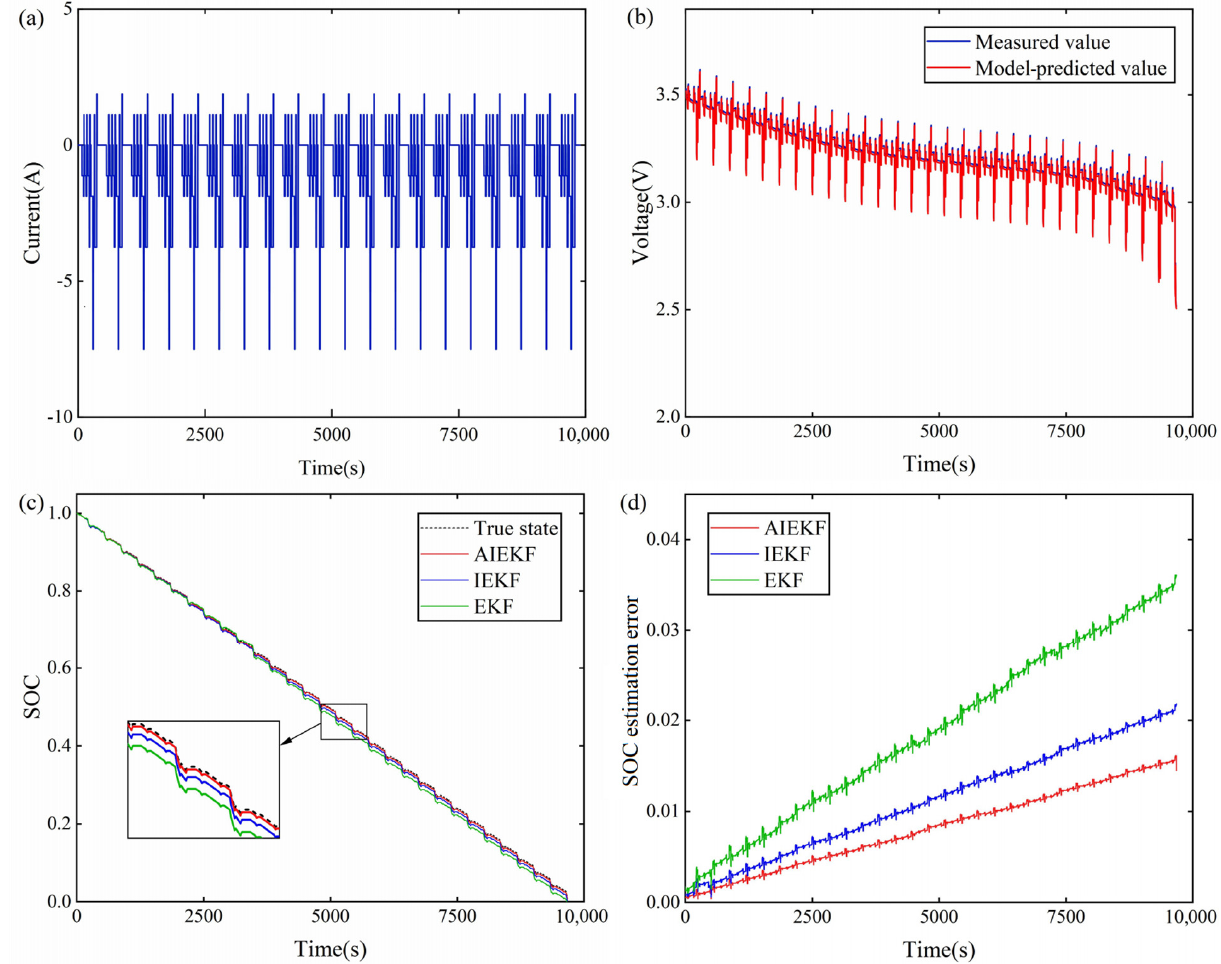
Figure 8. SOC estimation results of AIEKF, IEKF, and EKF under DST operating conditions: ( a ) current condition; ( b ) the model-predicted and the measured voltage; ( c ) SOC estimation results; ( d ) SOC estimation errors.